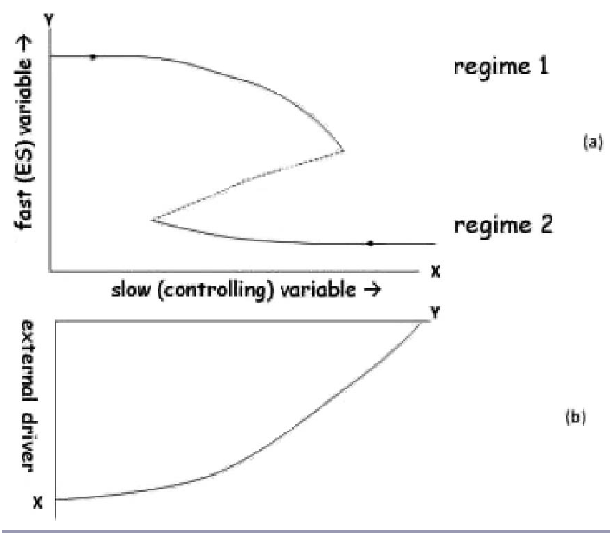
Fig. 2. External (or higher scale) drivers cause changes in the slow (controlling) variables (SV), as in part (b), which then in turn determine the amounts of the faster changing system goods and services (FV), as in part (a)